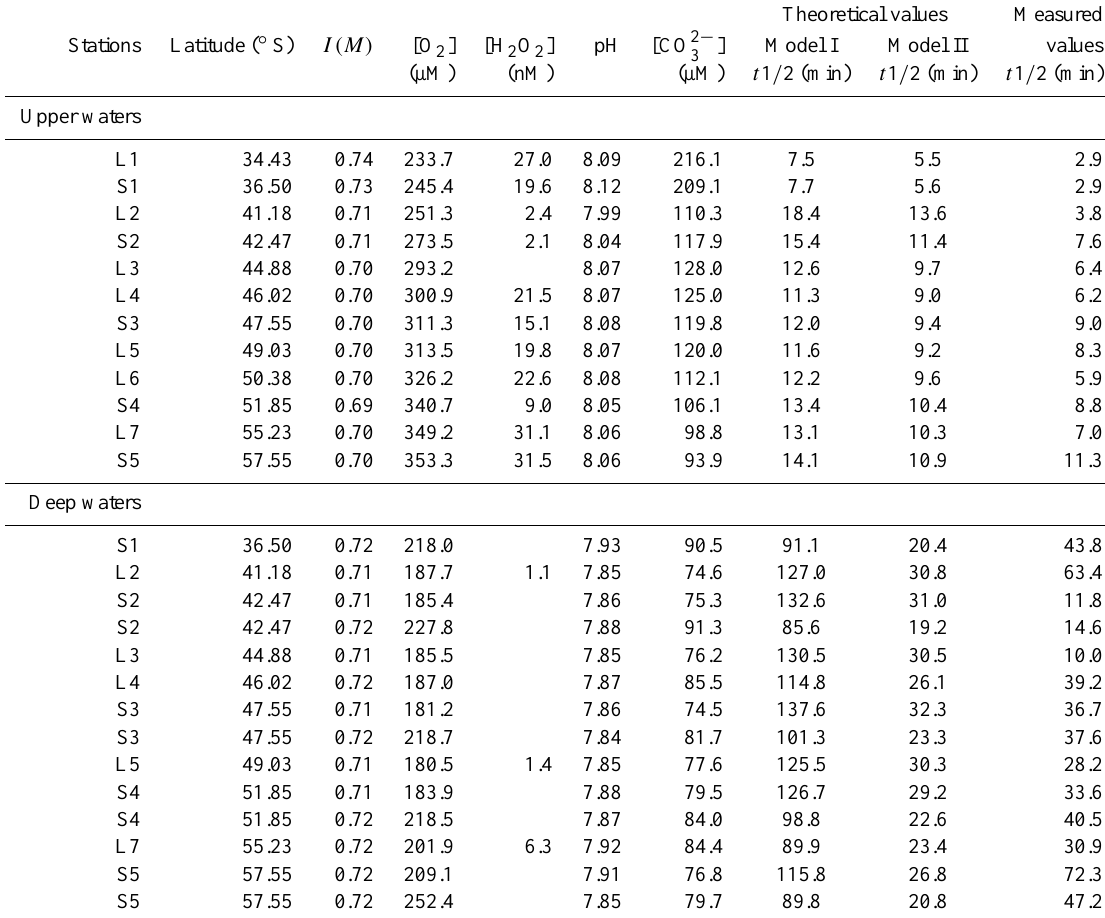
Table 3. Theoretical values of Fe(II) half lifes (in min) for surface and deep water samples at 4 ◦ C using models of Fe(II) oxidation kinetics (Santana-Casiano et al., 2005: Model I; Trapp and Millero, 2007: Model II; see Supplement). The ionic strength has been calculated from salinity using the equation I =(19.9201*S)/(1000–1.00488*S) (Millero,